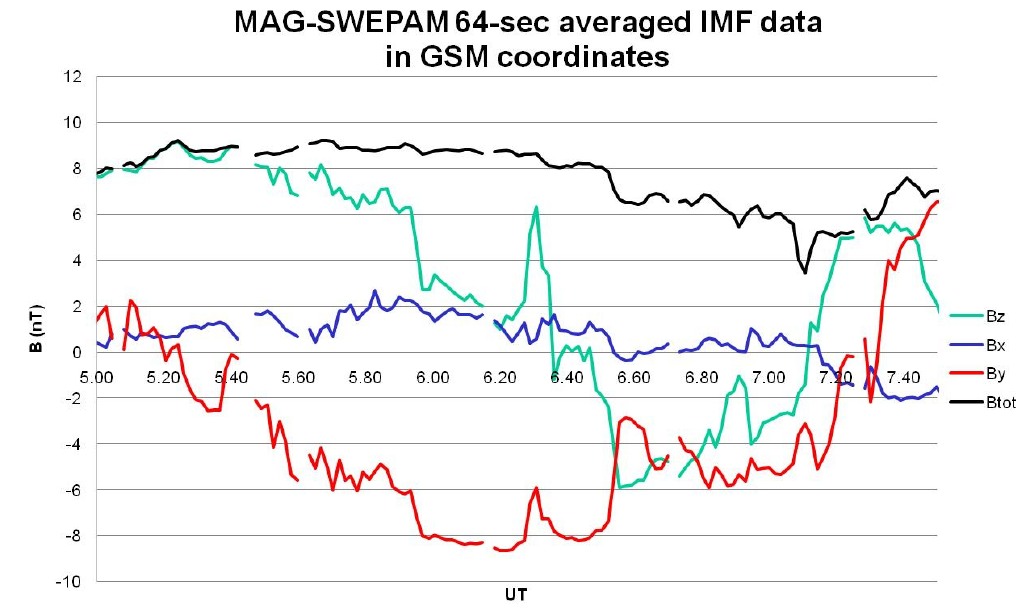
Fig. 3. ACE magnetometer data showing 64s averages of the IMF in GSM Figure 3: ACE magnetometer data showing 64 second averages of the IMF in GSM coordinates.